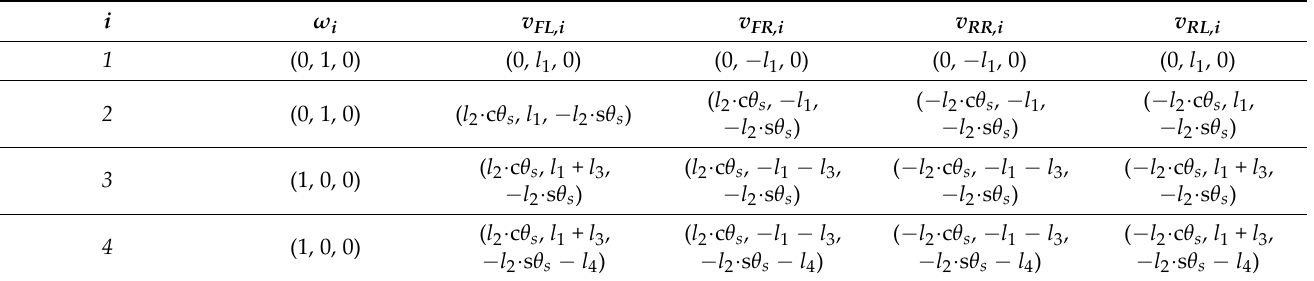
Table 1. Screw axes (_^O)S_(pq,i) =( ω _i,v_(pq,i) ) expressed in the frame {O} for the suspension kinematics from main